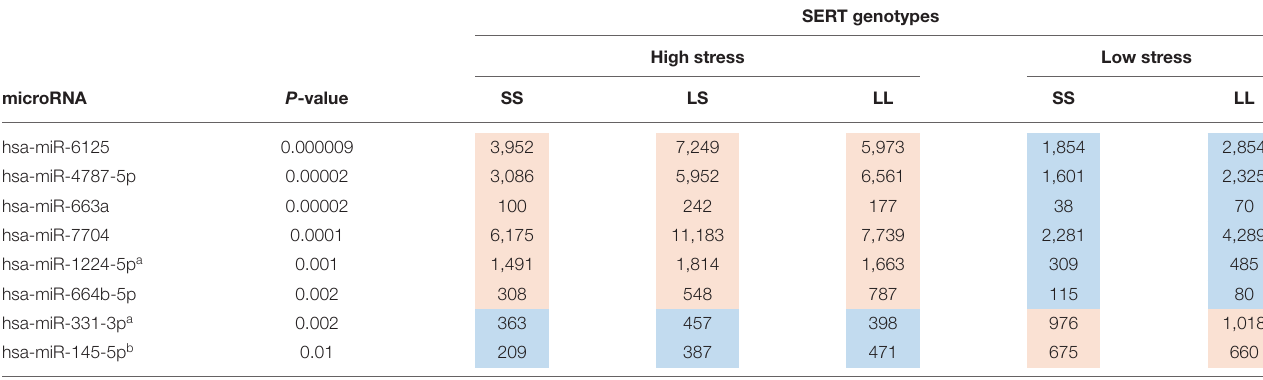
TABLE 2 | Eight DE microRNAs candidate for stress × SERT interactions (stress upregulated = red, downregulated = blue c ).